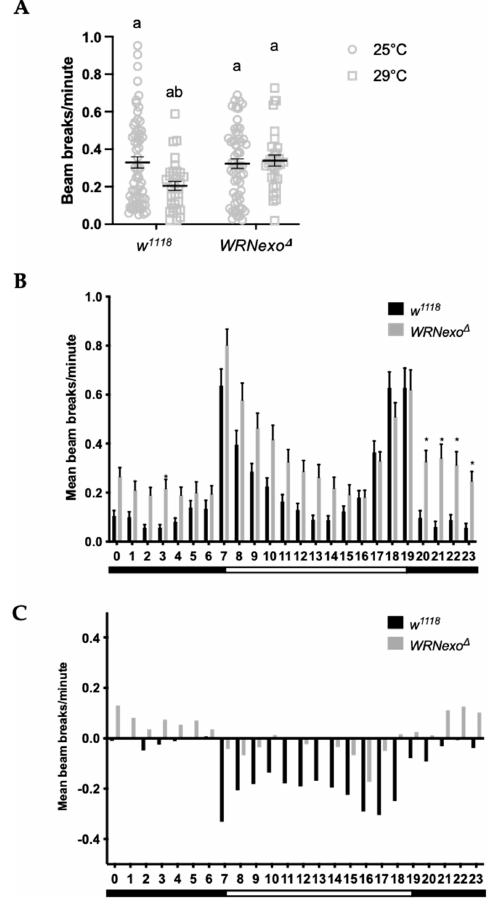
Figure 2. Activity in young WRNexo Δ females increases at elevated ambient temperature. ( A ) While overall activity declines for w 1118 females at 29 °C, WRNexo Δ activity does not change (Kruskal–Wallis test, letters denote statistically significant groups, p < 0.0001, ±SEM). ( B ) Activity peaks are evident at light transition periods represented by the black and white bars. There was a significant difference in activity distribution between w 1118 and WRNexo Δ at 29 °C (Kolmogorov–Smirnov test, p < 0.0001) and significant differences between mean hourly intervals from hour 20–23 (Kruskal–Wallis test, * p < 0.01, ±SEM, 25 °C: w 1118 n = 62, WRNexo Δ n = 62; 29 °C: w 1118 n = 32, WRNexo Δ n = 31. ( C ) Change in hourly activity levels for each genotype was calculated by subtracting activity levels at 25 °C from activity levels at 29 °C. Compared to w 1118 , WRNexo Δ females showed an increase in activity at night.